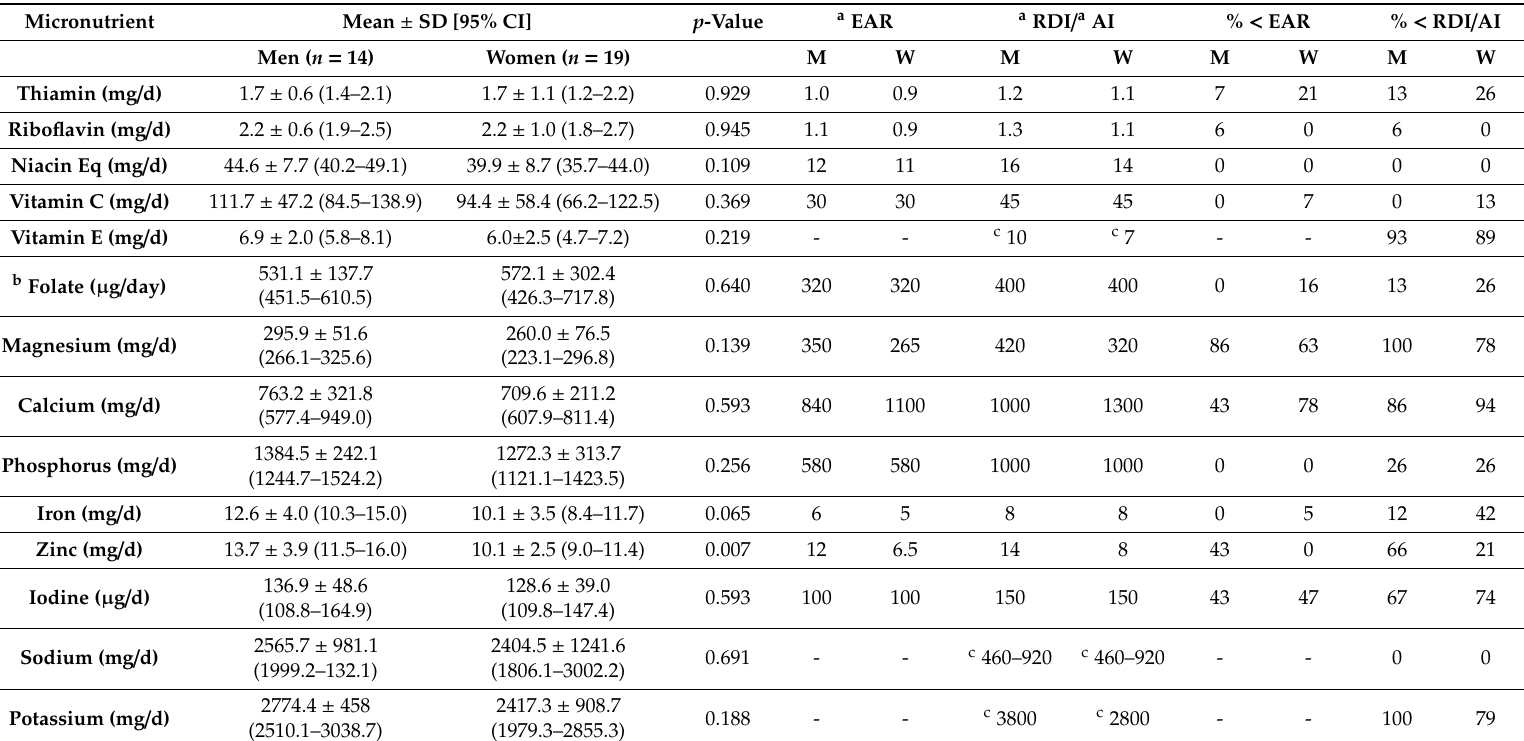
Table 3. Micronutrient intake among men and women with intellectual